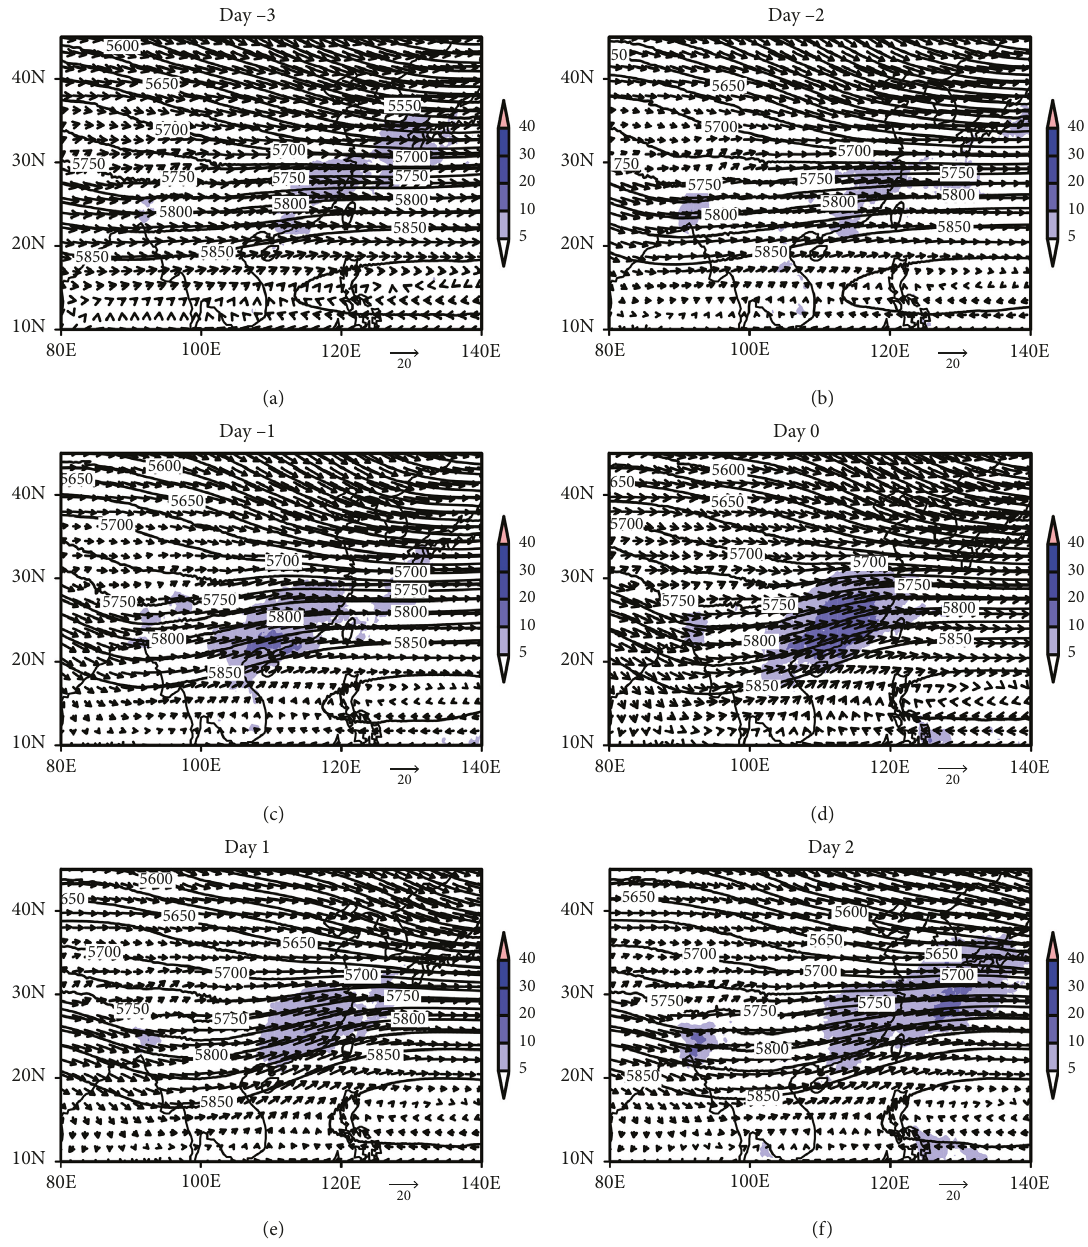
Figure 11: Composite of 500hPa wind ( vector , ms − 1 ), geopotential height ( contour , m), and PERSIANN rainfall ( shaded , mmday − 1 ) during the events associated with cold surge and upper-level